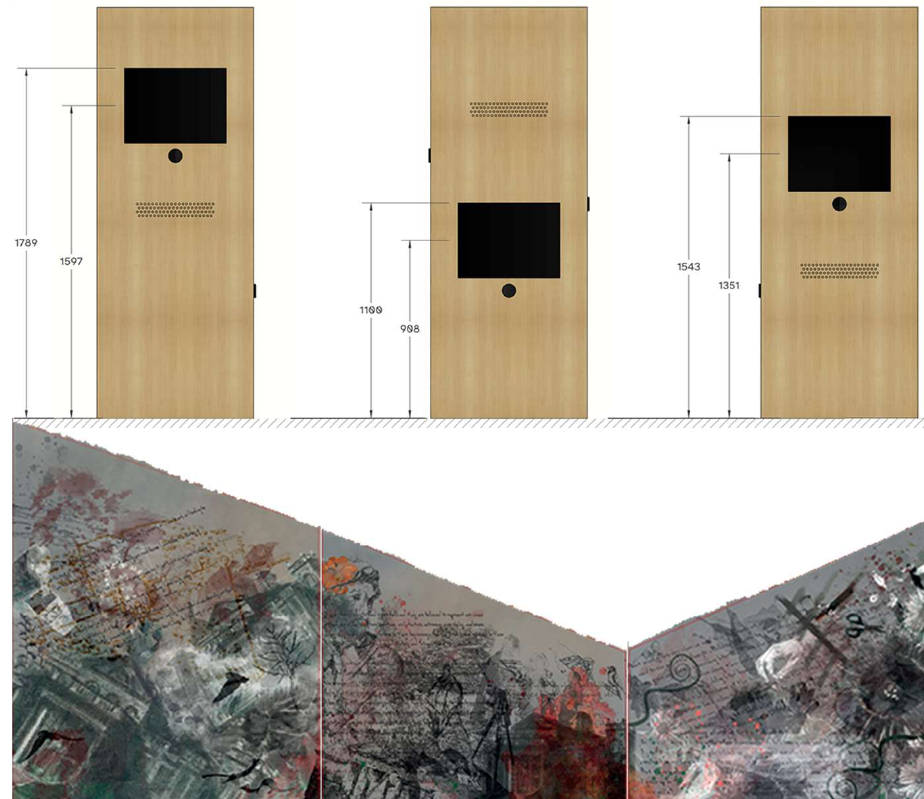
Figure 6. Loci Stories —visualising the dimensions and position of the three displays ( top , courtesy of Raskl and used with permission); and the three graphic panels ( bottom ).